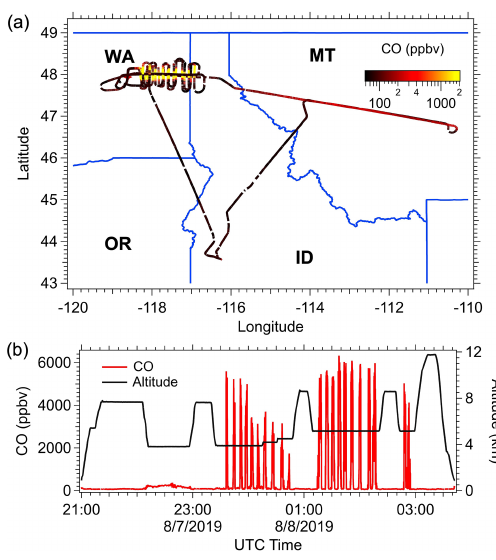
Figure 1. (a) Example flight track on 7 August 2019, targeting smoke plumes emitted from the Williams Flats fire, where the flight track color gives the CO mixing ratio. (b) Time series of CO (red) and aircraft altitude